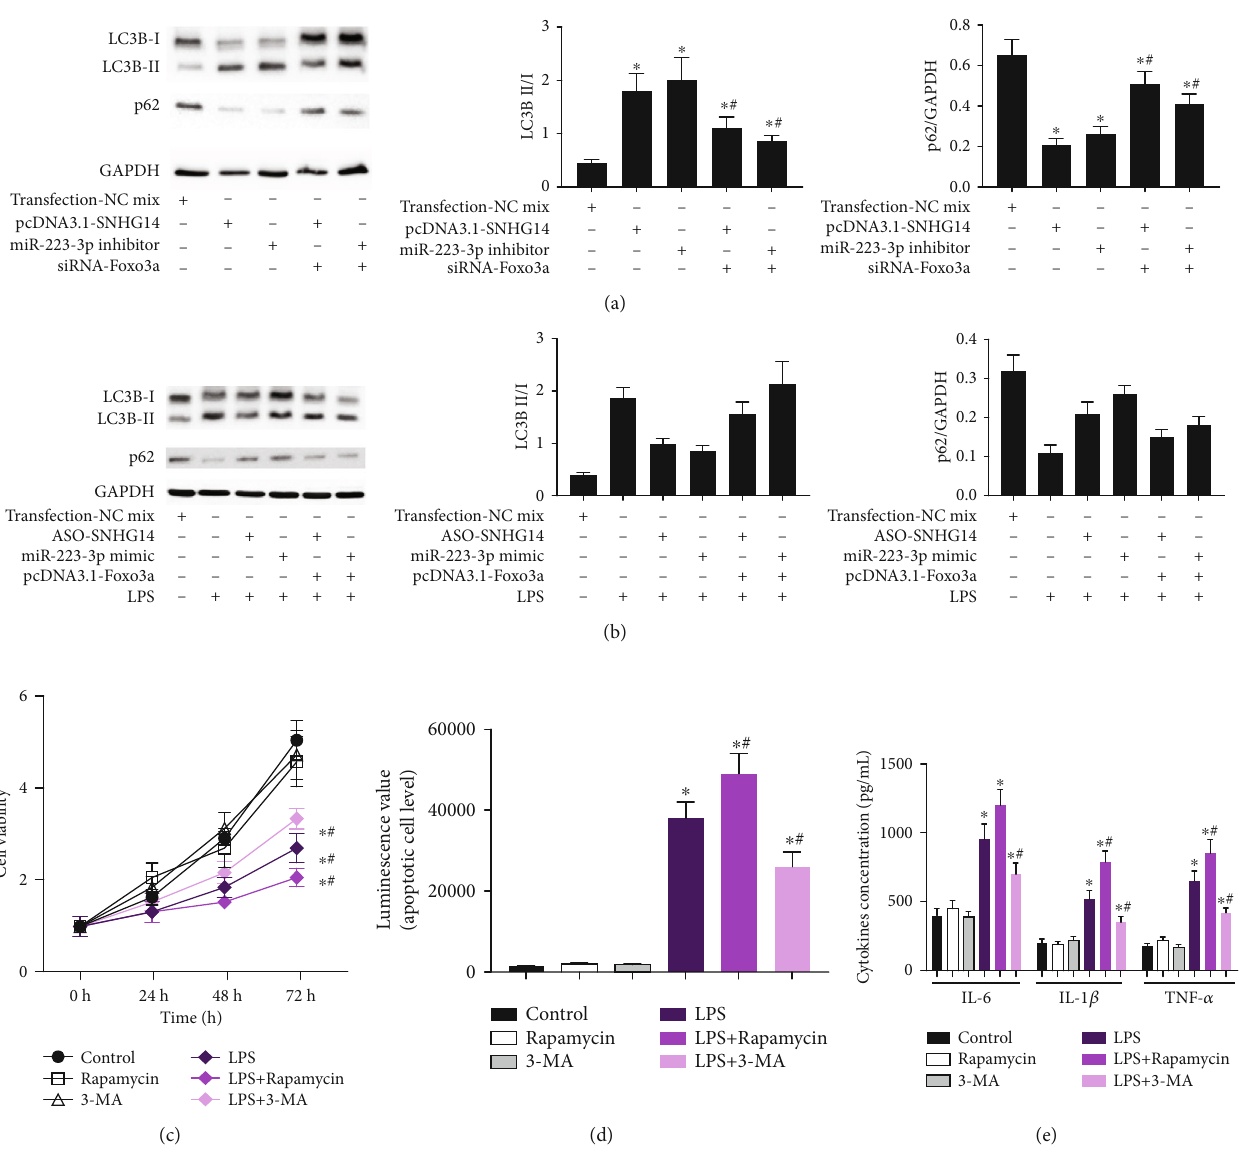
Figure 6: lncRNA-SNHG14/miR-223-3p/Foxo3a axis regulated autophagy in A549 cells. (a) A549 cells were transfected with pcDNA3.1- SNHG14, miR-223-3p inhibitor, pcDNA3.1-SNHG14+ siRNA-Foxo3a, and miR-223-3p inhibitor+siRNA-Foxo3a. Autophagy markers including LC3B II/I and p62 were detected using western blotting. (b) Cells were transfected with ASO-SNHG14, ASO-SNHG14 +pcDNA3.1-Foxo3a, miR-223-3p mimic, and miR-223-3p mimic+pcDNA3.1-Foxo3a, respectively. Autophagy markers were detected under LPS treating condition. (c) Cells were treated with rapamycin or 3-methyladenine. Cell viability (c), apoptosis (d), and cytokines (e) were measured under LPS treating condition. ∗ P < 0 : 05 compared with transfection negative control or LPS untreated control; # P < 0 : 05 compared with cells without cotransfection of siRNA-Foxo3 or pcDNA3.1-Foxo3a in (a, b). # P < 0 : 05 compared with cell without treatment of rapamycin and 3-methyladenine in (c,